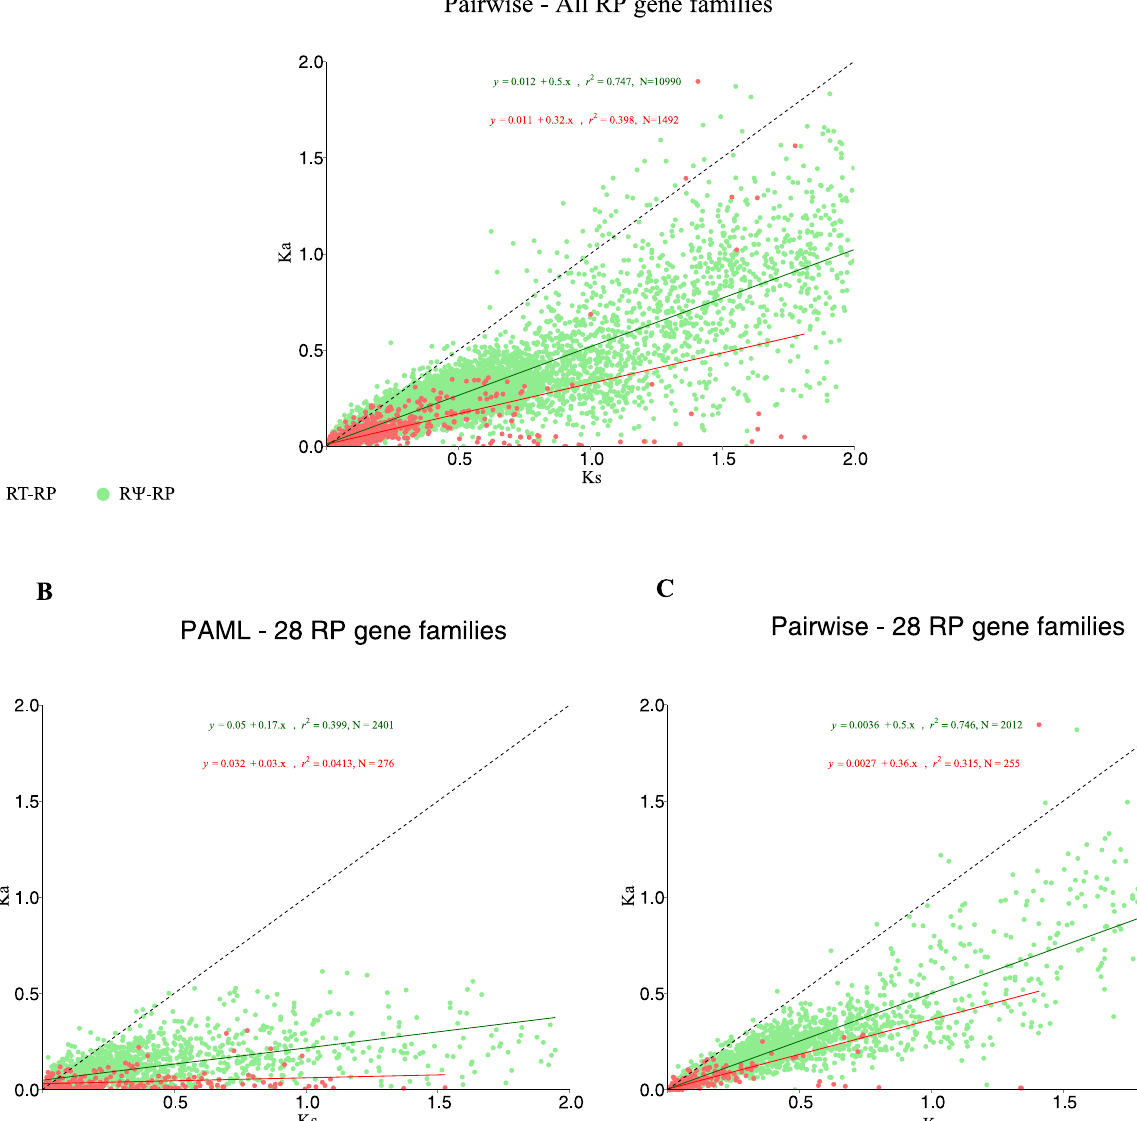
Figure 6. Scatterplots for pair-wise and branch-wise Ka against Ks values show that both methods capture the strong selective pressure acting on the RP gene duplicates. Plot of Ka against Ks for RP families with branch-wise and pair-wise methods. A) Distribution for all 76 RP families using the pair-wise selective pressure calculation method. Red dots represent RT-RPs and green dots represents R Y -RPs. The black solid line represents Ka = Ks and the red & green line are the best line of fits for the distribution of RT-RPs and R Y -RPs respectively. B) Distribution for 28 RP families analyzed by codeml program in PAML. C) Distribution of the aforementioned 28 families from PAML analysis using the pair-wise